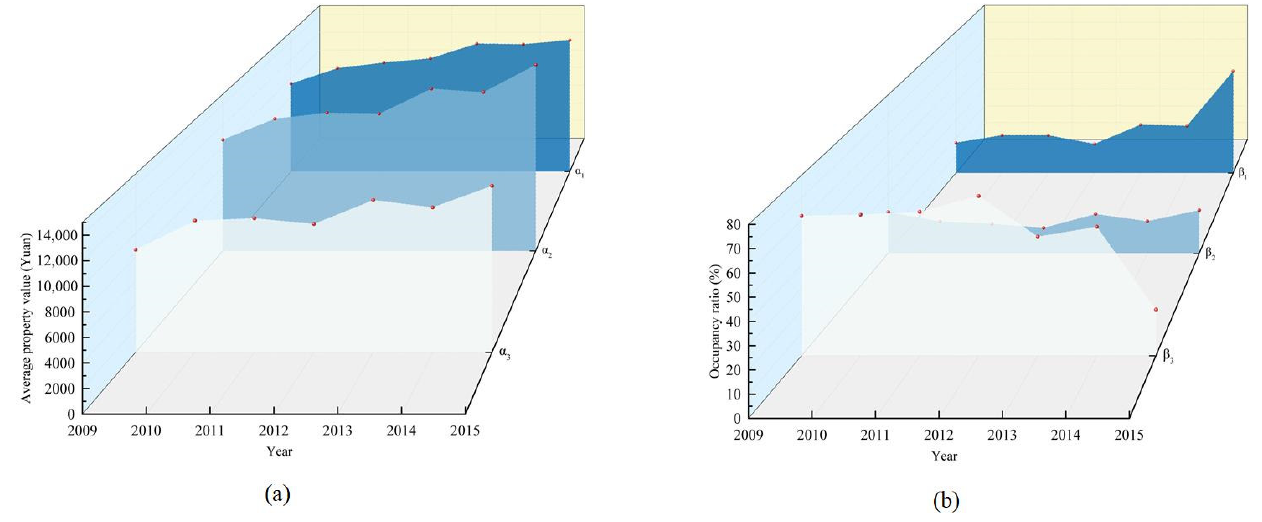
Table 2. Average property and occupancy ratio of the residential, commercial and industrial land.